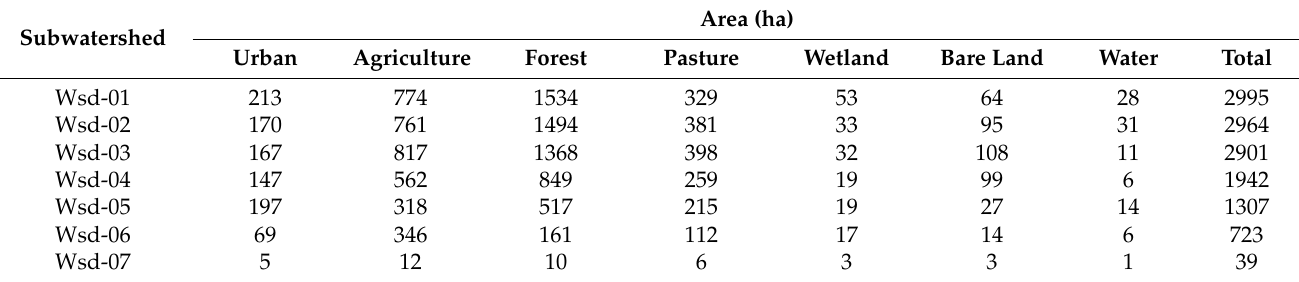
Table 1. Land use area of subwatersheds where model was